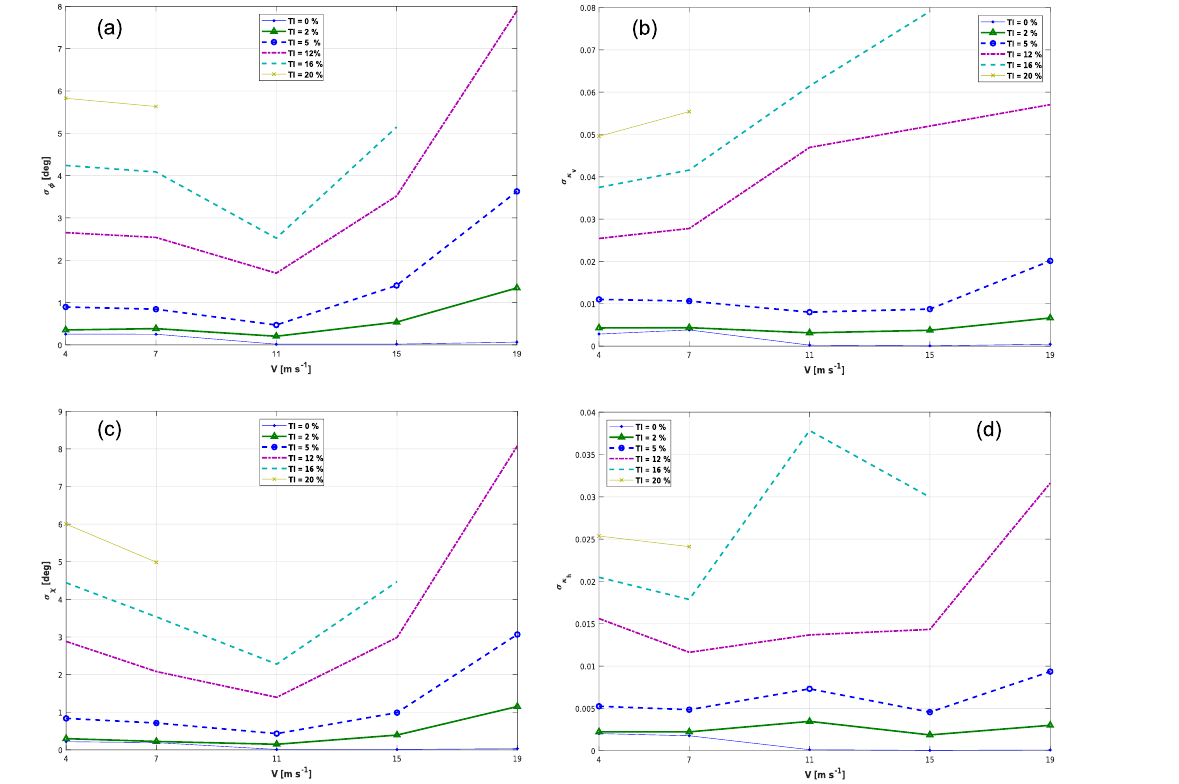
Figure 14. Standard deviation of the estimation error of yaw misalignment (a) , vertical shear (b) , upflow angle (c) and horizontal shear (d) as functions of wind speed for varying TI levels. All curves refer to the nonlinear observer results.